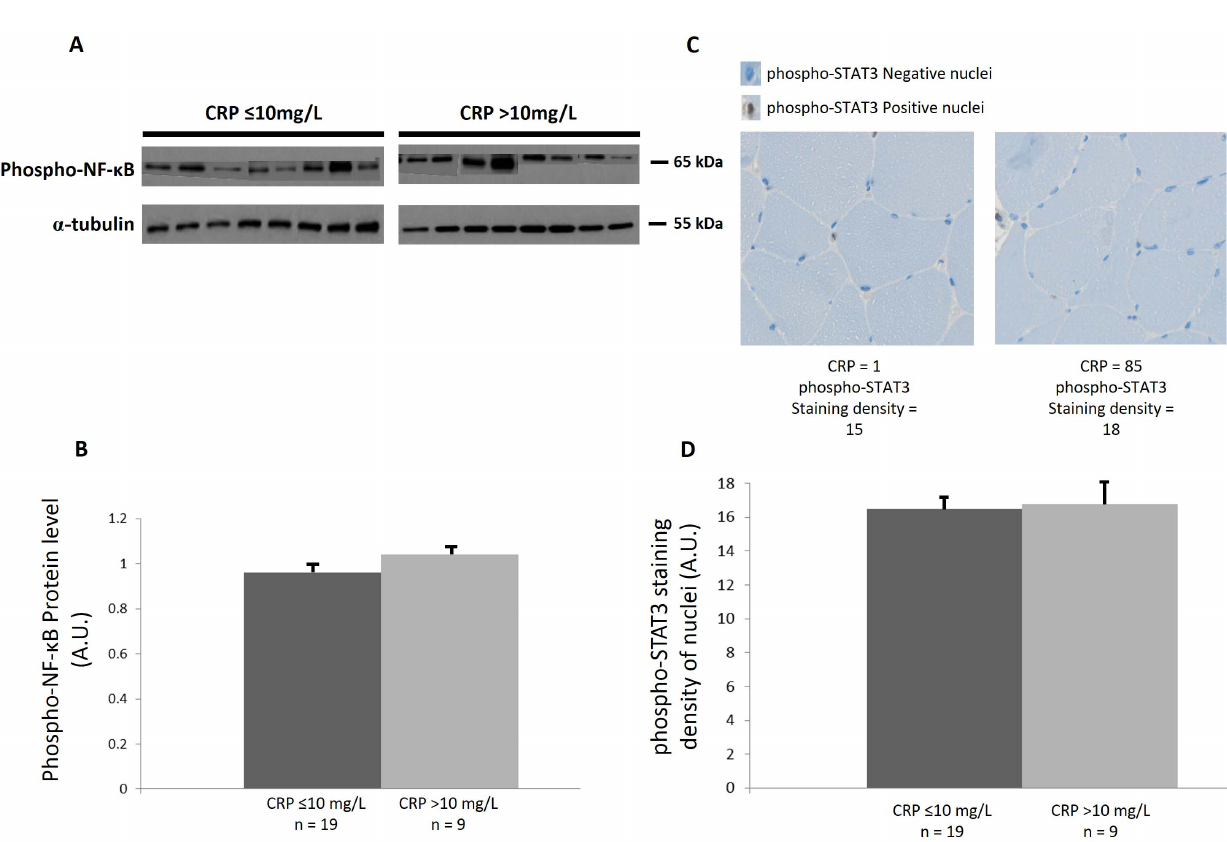
Figure 5. Inflammatory pathways in patients with (CRP . 10 mg/L) and without (CRP # 10 mg/L) systemic inflammation. (A) Western blot analysis in the presence or absence of systemic inflammation with indicated antibodies, a -tubulin was used as a loading control. (B) Graph shows the mean ( 6 SEM) protein level of phospho-NF- k B, represented in arbitrary units (A.U). (C) Representative immunohistochemistry and nuclei count of phospho-STAT3 (area shown is representative of field) of a patient with or without systemic inflammation. (D) Graph shows the staining density of phospho-STAT3 nuclei (A.U.) ( 6 SEM) in the presence or absence of systemic inflammation.